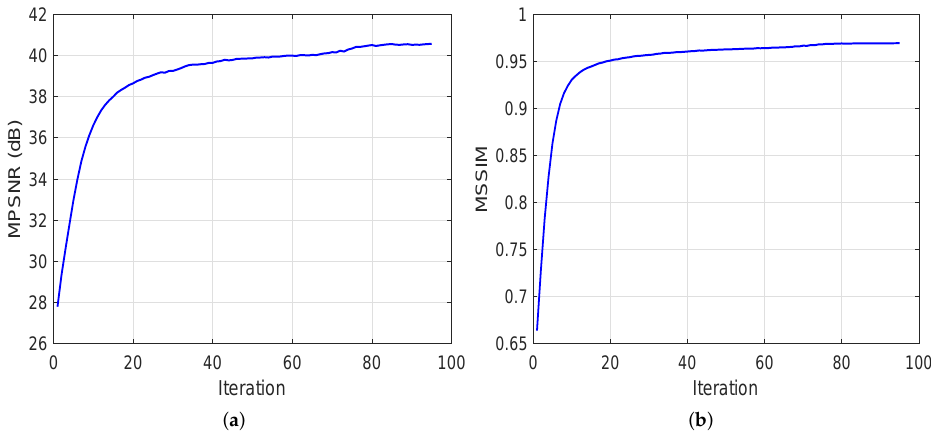
Figure 14. MPSNR and MSSIM as a function of iteration for the proposed method with WDC dataset. ( a ) MPSNR VS iteration; ( b ) MSSIM VS